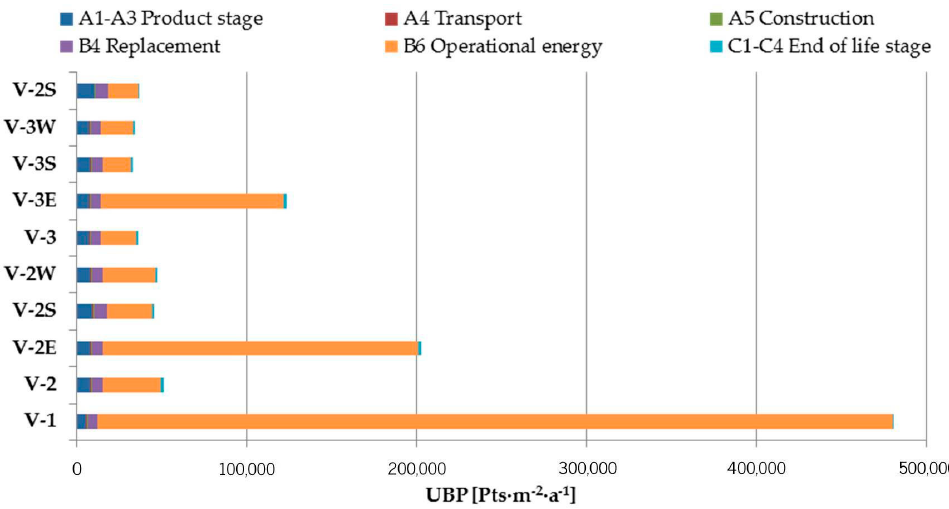
Figure 4. Overall environmental impacts (OEIs) of individual variants of the house per 1 m 2 of treated floor area (TFA) and year of operation in relevant LCA stages and modules, according to EN 15978.